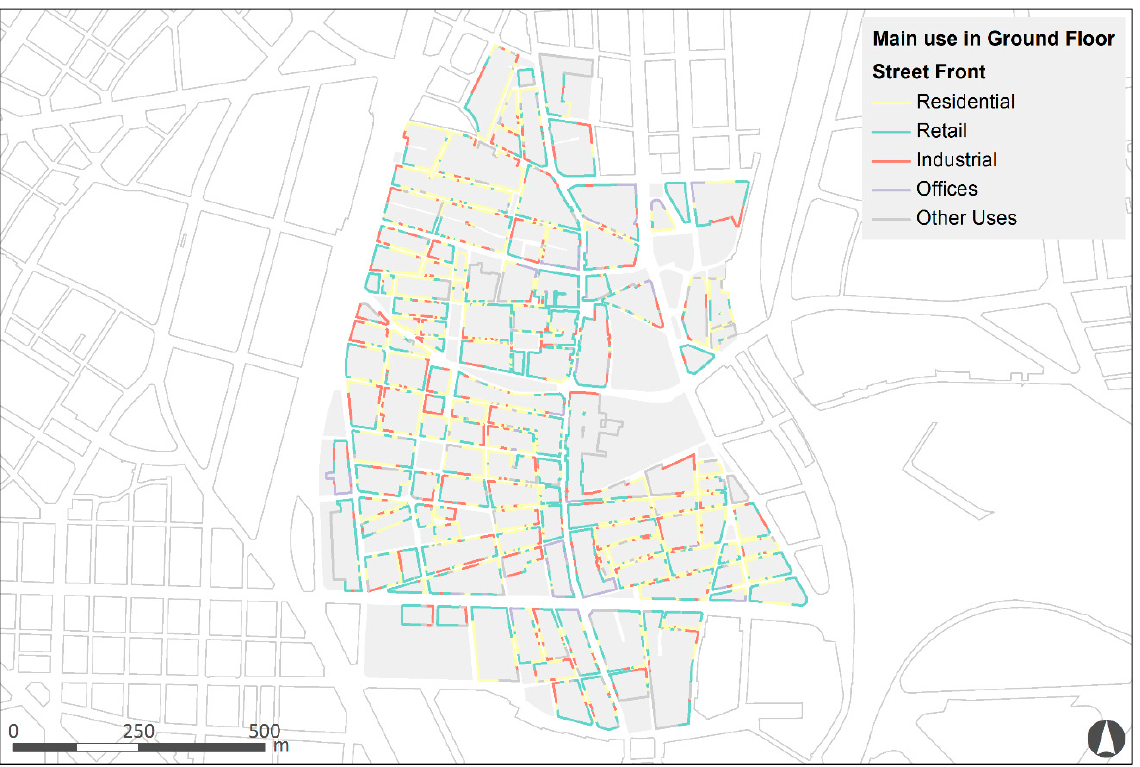
Figure 21. Map of parcel fronts colored by main use at street